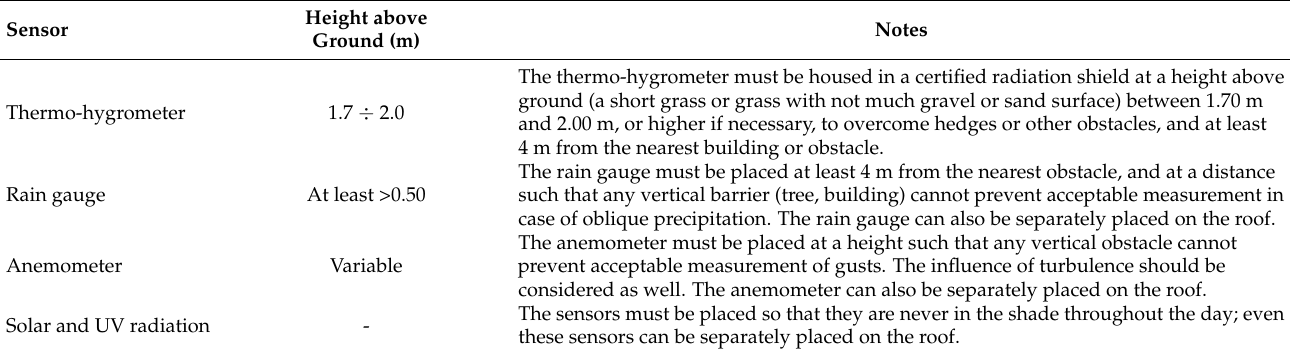
Table 4. Example of requirements for the configuration of a